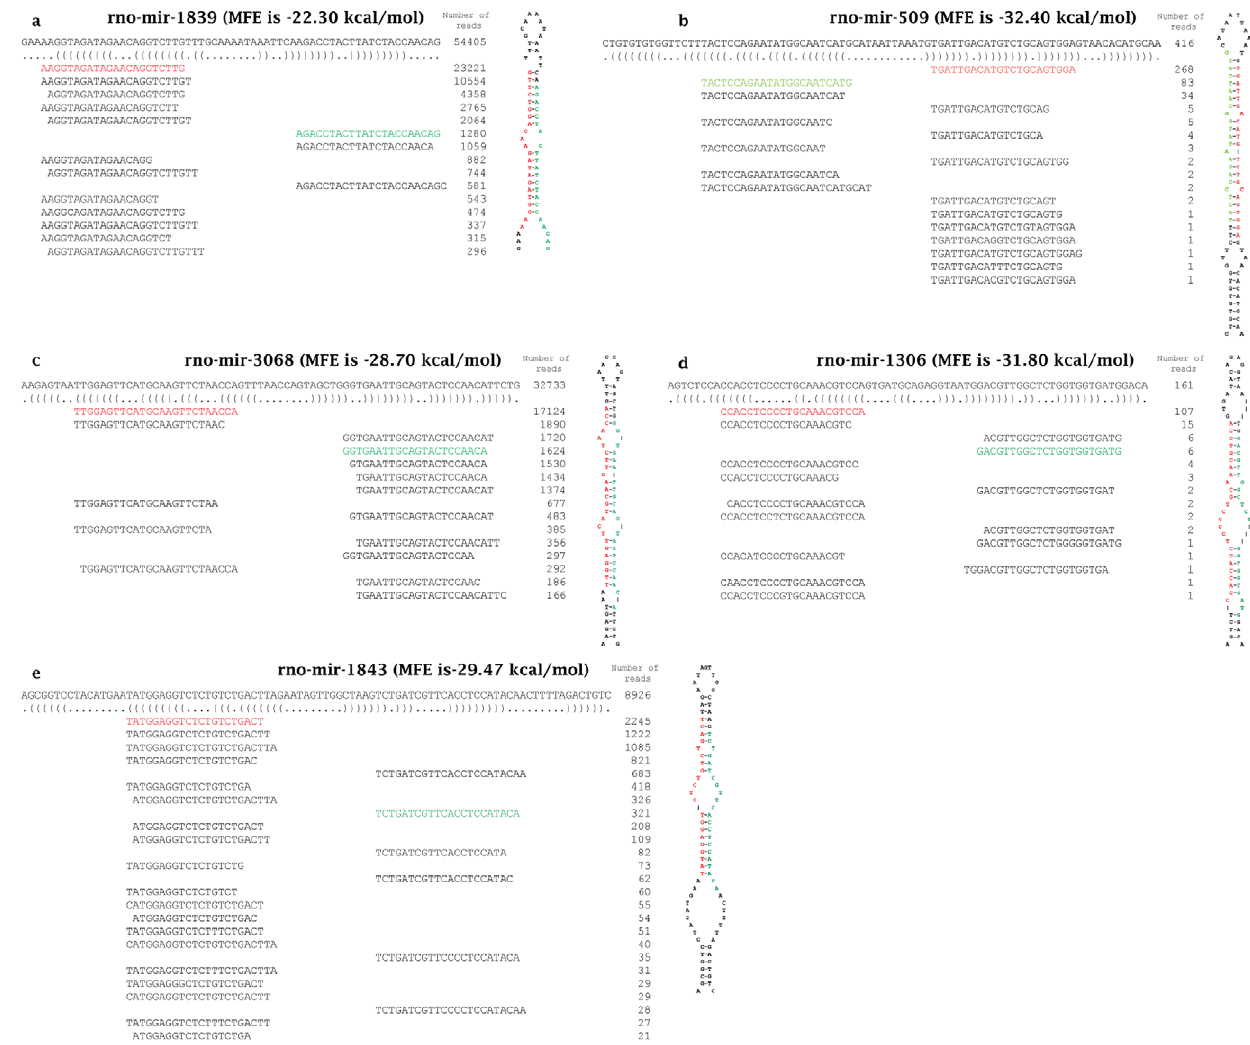
Figure 2. The sequences and secondary structures of five novel rat pre-miRNAs homologous to known miRNAs in other species. 2a. rno-mir-1839. 2b. rno-mir-509. 2c. rno-mir-3068. 2d. rno-mir-1306. 2e. rno-mir-1843. The sequences of 5 novel rat homologous pre-miRNAs hairpin are depicted above their dot-bracket notation secondary structures as determined by RNAfold [62,63] using minimum free energy algorithm (MFE). RNAfold is a widely used webserver to predict RNA secondary structure. Below the dot-bracket notation secondary structures of these novel rat homologous pre-miRNAs, each of the small RNA sequences that matched those pre-miRNAs hairpin are listed, with the number of reads representing each sequence at its right side. The mature and the mature* sequences are marked in red and green respectively. The MFEs of those rat novel pre- miRNAs predicted by RNAfold are above their sequences. The single nucleotide extension isomirs of the mature* sequences had higher read counts than the mature* sequences with perfect 2 nt 3 9 overhang in two miRNAs (rno-miR-3068-3p and rno-miR-1843-3p).